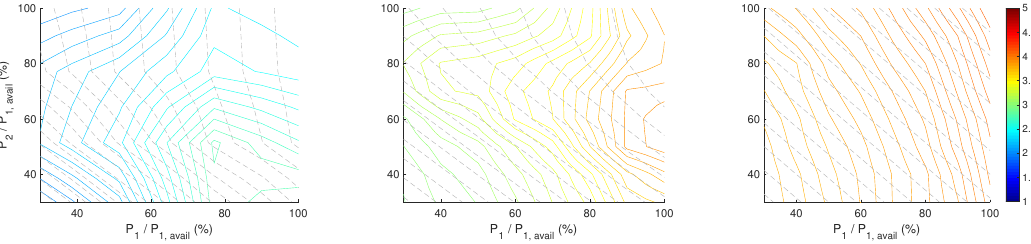
Figure 14. Impact of wind conditions and turbine power set-points on simulated sum BRF damage equivalent loads of two turbine array. Contour lines show sum BRF normalised loads. Ambient mean wind speed is 8, 12 and 16 m/s from left to